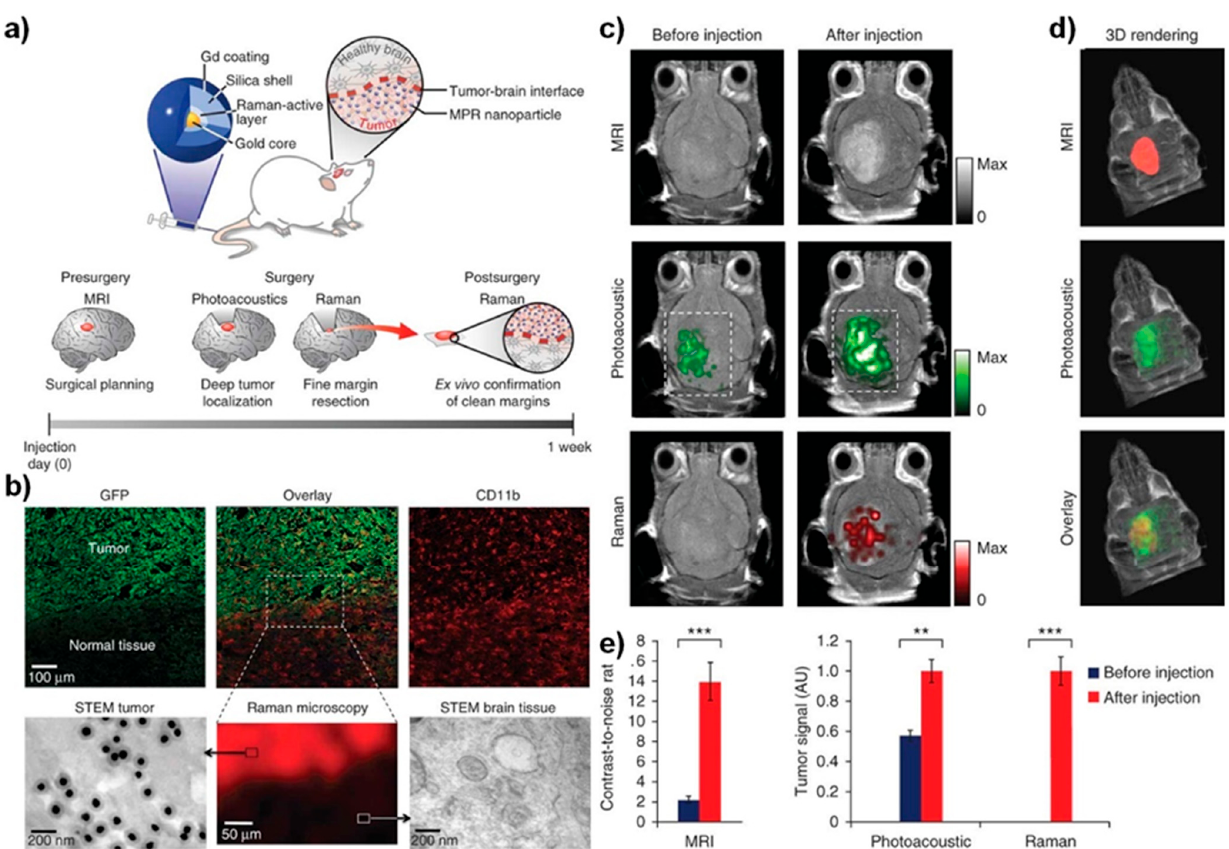
Figure 2. Triple-modality nanoparticle delivery and imaging concept to the brain tumor model. ( a ) Delivery of nanoparticles circulates in the bloodstream; they diffuse through the disrupted blood– brain barrier and are then sequestered and retained by the tumor; upon employing photoacoustic imaging, the high resolution, and deep tissue penetration guide tumor resection intraoperatively in the surgical room. Following imaging strategies of the brain specimen can subsequently be examined as an imaging probe ex vivo to validate clear tumor margins. ( b ) Immunohistochemistry of the tissue sections from the margin of the brain tumor stained for glial cells under confocal laser scanning microscopy. Scanning transmission electron microscope (STEM) images validated the presence of delivered nanoparticles in the brain tissue, whereas no such nanoparticles were seen in the healthy brain tissue. ( c ) Two-dimensional axial MRI, Photoacoustic, and Raman images; ( d ) three- dimensional (3D) rendering of magnetic resonance images with the tumor segmented overlay of the three-dimensional photoacoustic images. ( e ) Corresponding quantitative signals of the nanoparticles from images shown in ( c , d ). Shown data represents mean ± S.E.M; *** p < 0.001, ** p < 0.01. Reprinted with permission from Ref. [43].Copyright 2021 Springer